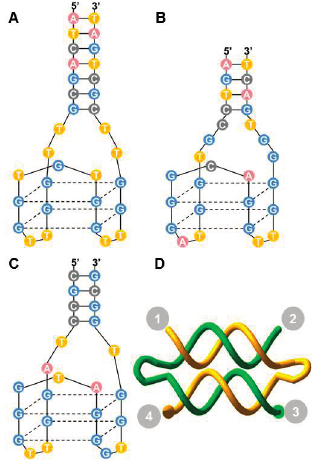
Figure 2. Thrombin-binding aptamers and DNA weave tile. ( A ) Apt A (also named HD1) with a 7-bp stem and -TT- linkers at the ends; ( B ) Apt B (also named HD22); ( C ) Apt P (also called NU172). The structure shown is a model due to the absence of a published crystal structure; ( D ) A two-helix weave tile (2HT) with the four ends numbered for aptamer positioning and assembly